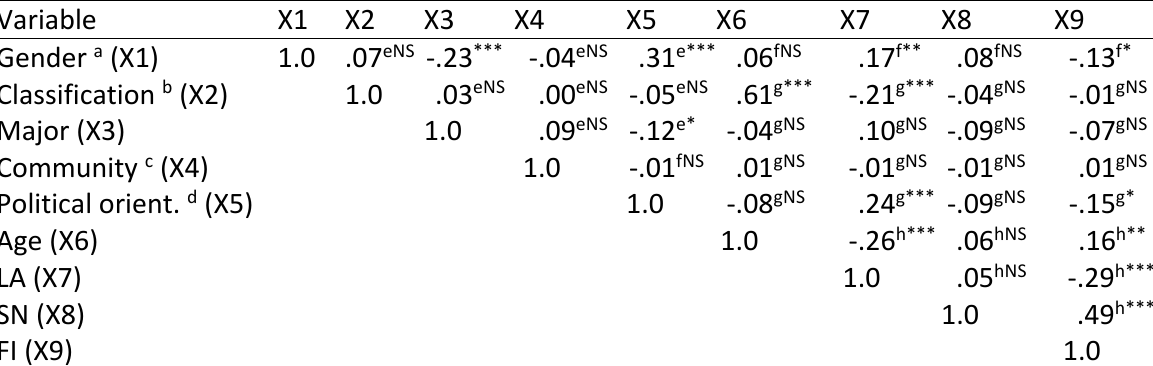
Intercorrelations between Demographic Characteristics, LA and SN Factors, and FI Variable